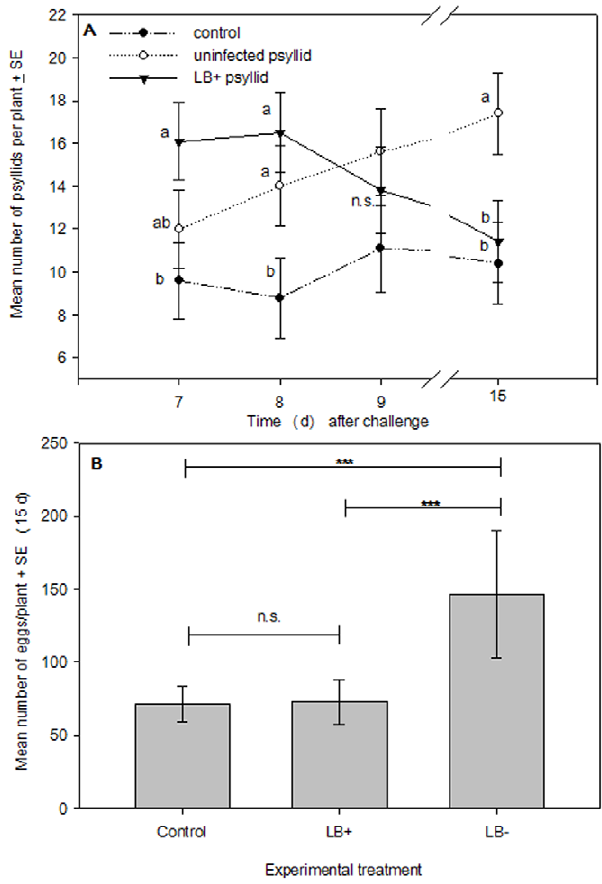
Figure 2. Psyllid settling and oviposition preferences. (A) Mean number of psyllids/plant/d -1 6 SE in a cage-release experiment ( N =45) testing the effects of S. tuberosum infection status on B. cockerelli settling behaviors, letters denote Tukey’s HSD test; and (B) pairwise comparisons of mean number of eggs/plant 6 SE at the end of the experiment (Bonferroni adjusted Type I error rate: a = 0.016; *** P , 0.001).